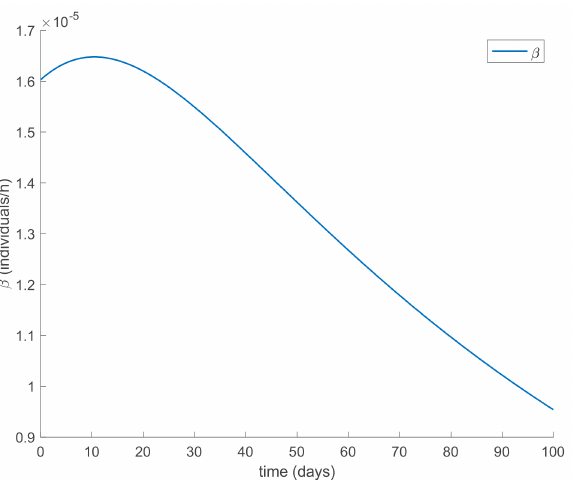
Figure 2. Evolution of the SIR model when λ = 0.9 is used in Equation (30) to determine the value of β .